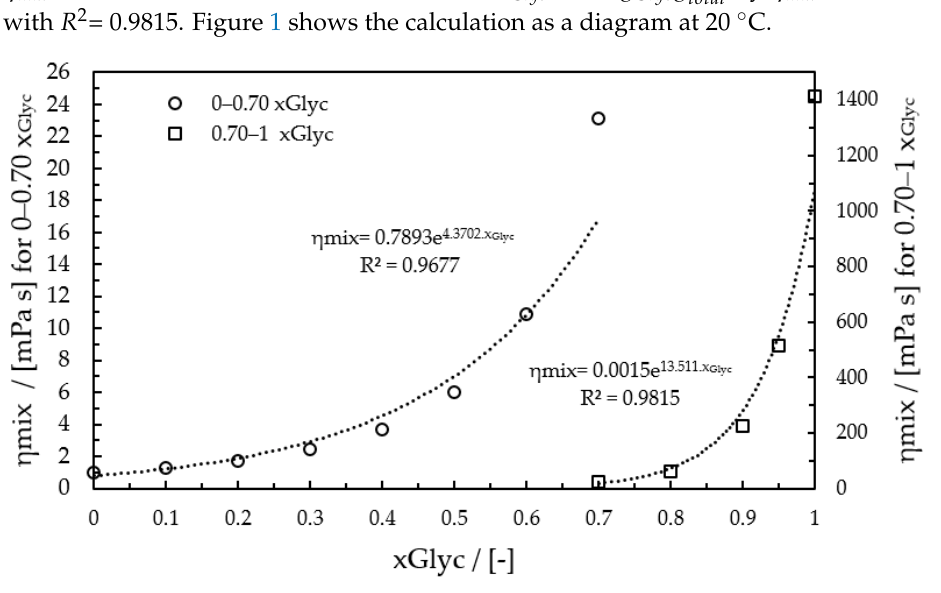
Figure 1. Dynamic viscosity with Equation (1) at 20 °C for the imaging analysis Software.